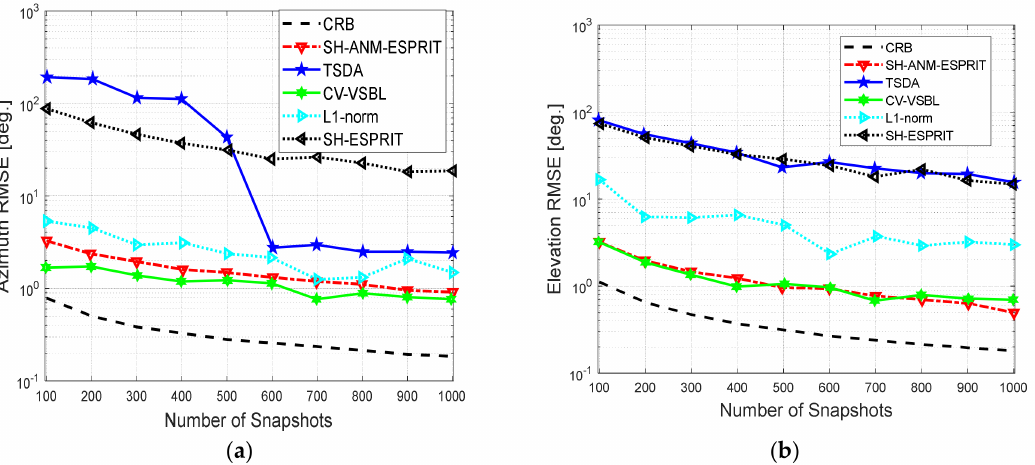
Figure 7. Comparison of performance with different value of snapshots under correlated sources at ( θ , ϕ ) = ( 30 ◦ ,60 ◦ ) and ( 36 ◦ ,138 ◦ ) , α = 0.8. ( a ) Azimuth. ( b )